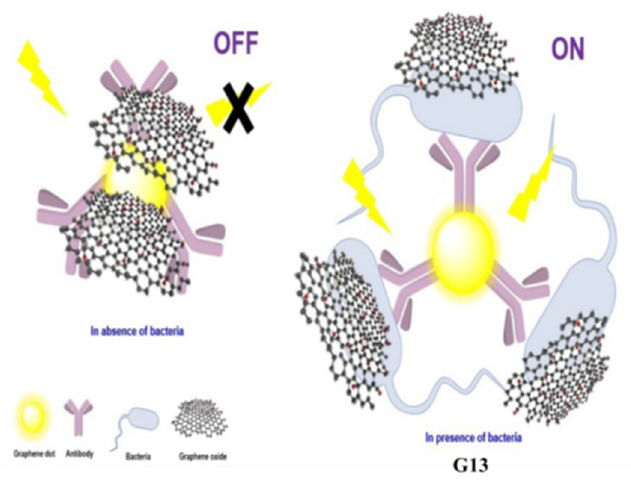
Figure 15. Schematic diagram of Campylobacter jejuni detection using the antibody GQDs/GO ( G13 ). Reprinted from [70] with permission from Elsevier.